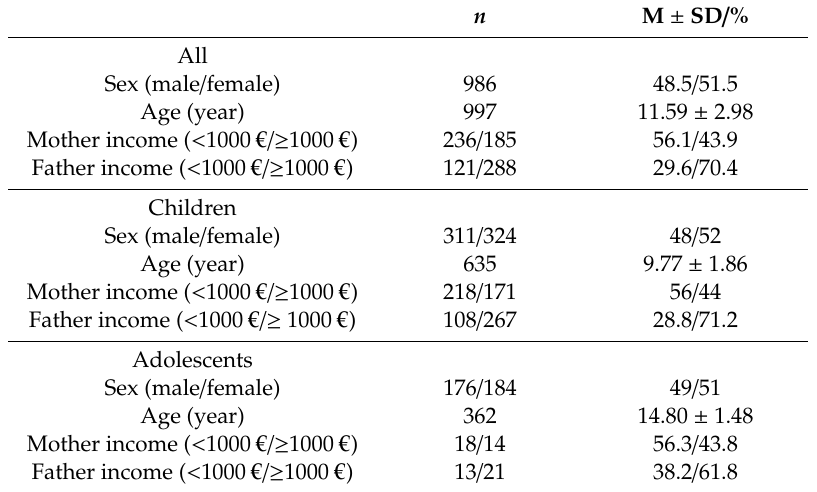
Table 1. Descriptive characteristics of the total sample and separately by children and